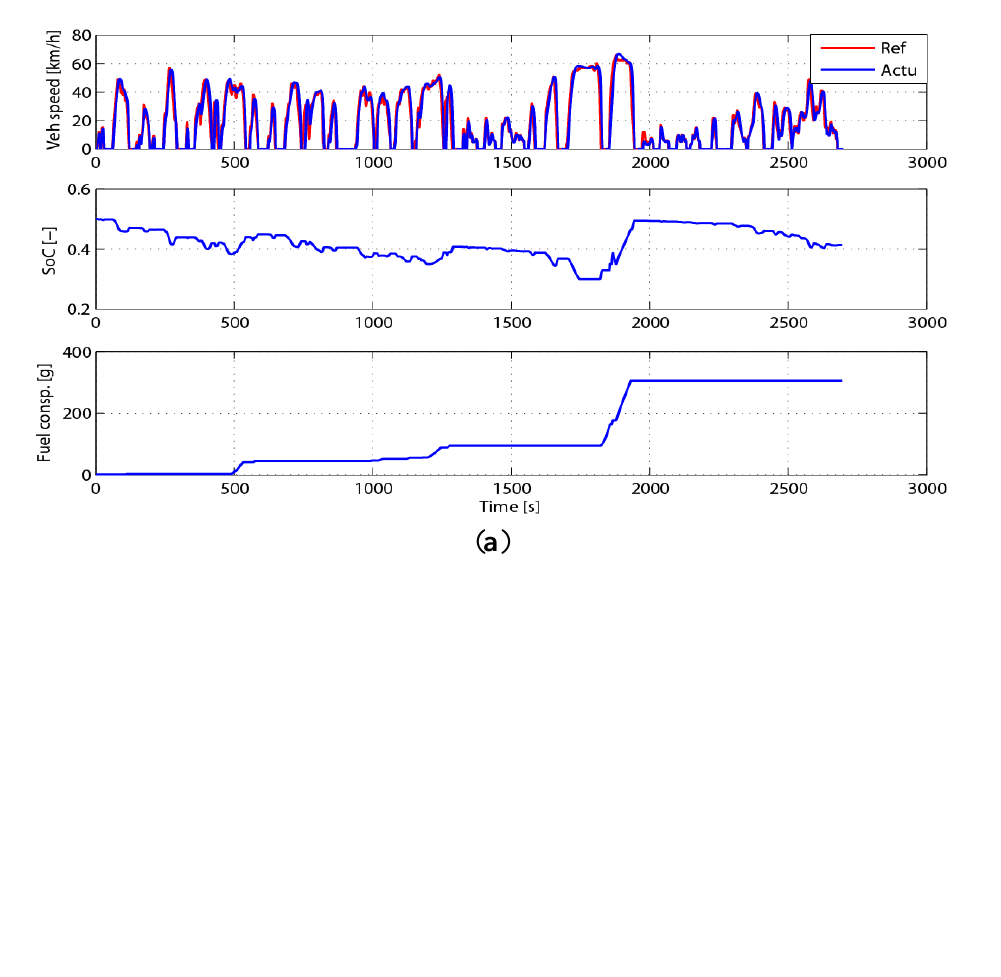
Figure 14. Result with the full-policy for the third Monday speed profile. ( a ) Vehicle speed, SoC and fuel-electricity consumption; ( b ) batter powery, demand power and engine, generator and motor power outputs; ( c ) engine, generator, motor speeds and their torques; ( d ) engine operating point